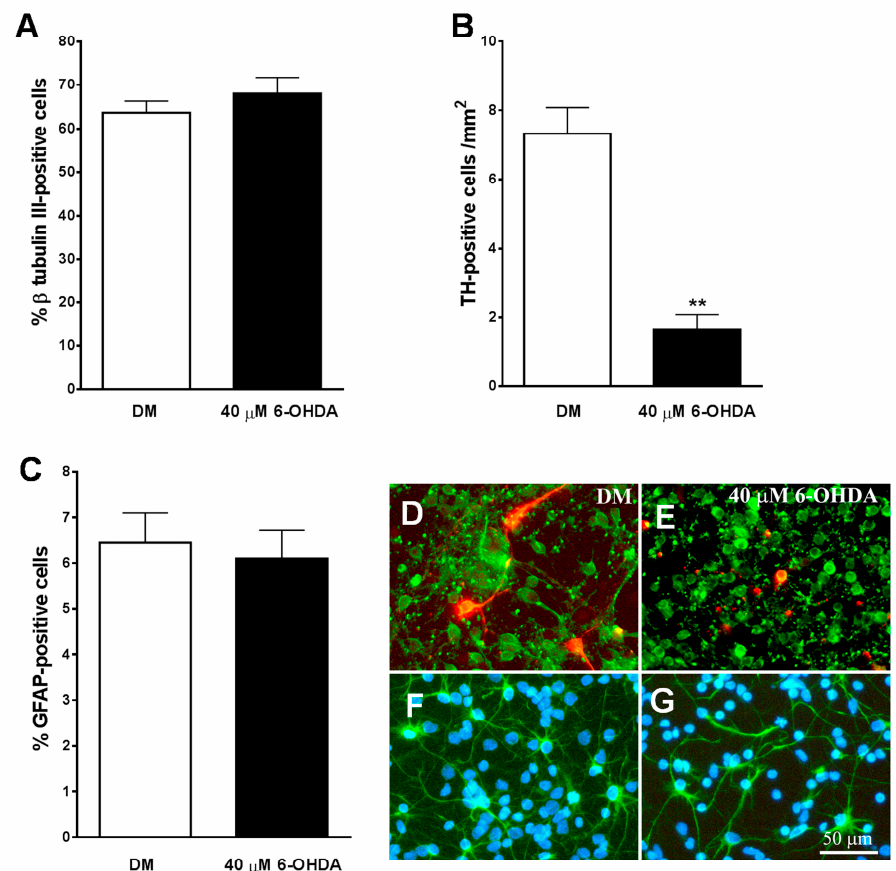
Figure 6. E ff ect of 6-OHDA on cultures of mesencephalic neurons. ( A – C ) show the e ff ect of 40 µ M of 6-OHDA on total population of neurons ( A ), tyrosine hydroxylase (TH)-positive dopaminergic neurons ( B ), and astrocytes ( C ). Note how the neurotoxin specifically decreases the population of TH-positive neurons ( B ). ( E ) shows how in the presence of 6-OHDA, both the total population of neurons β -tubulin III-positive (( D , E ) in green) and the TH-positive dopaminergic neurons (( D , E ) in red) lost their neuritic extensions and had a smaller size of their cell bodies, as compared with those cells grown in DM ( D ). ( F , G ) show immunostaining for GFAP-positive astrocytes (green) and cell nuclei stained with Hoechst (blue). Note how 6-OHDA ( G ) did not a ff ect to this cell population. The results in ( A – C ) represent the mean ± SEM of 8 coverslips from 3 independent experiments. ** p ≤ 0.01 vs. DM (t-test). Scale bar 50 µ